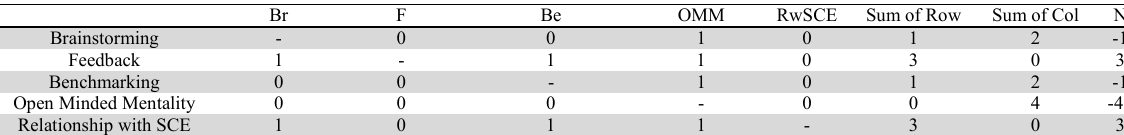
Place Alternative